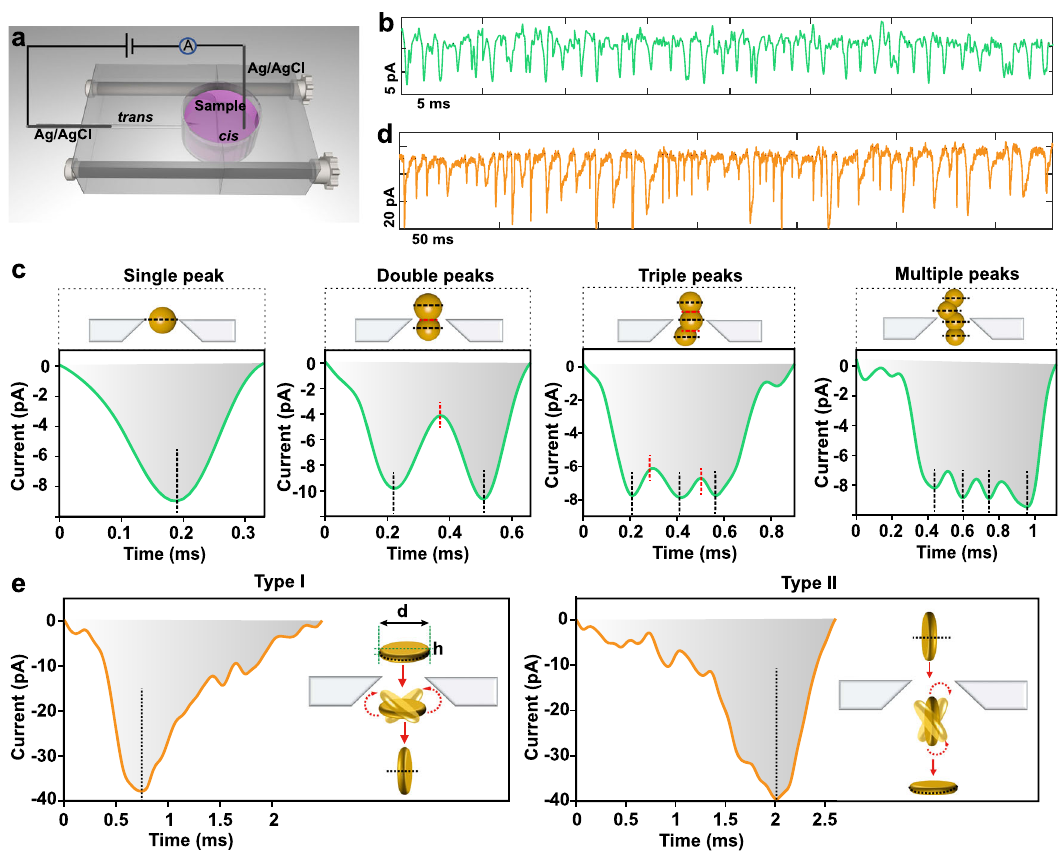
Fig. 2 Nanopore analysis of Au nanospheres and Au nanoplates. a Schematic of the nanopore experimental setup with a nanopipette and fl uid compartments con fi ned by polymethyl methacrylate (PMMA). The sample is added to the cis chamber in a 5 mM KNO 3 solution. 50 mM KNO 3 is fi lled in the trans chamber. b Concatenate events from Au nanospheres translocation test using a ~20 nm quartz nanopore at a 1 V bias voltage. A total of 2612 events were obtained from the Au nanospheres. c Typical nanopore current – time peak shape dependence of Au nanospheres coalescence states. Schematic of Au nanospheres translocation. d Concatenate events from Au nanoplates translocation test using a ~120 nm quartz nanopore at a bias voltage of 300 mV. A total of 761 events were obtained from the Au nanoplates. e Typical current – time peak shape for Au nanoplates. Schematic illustration of possible rotational tumbling of Au nanoplates in the nanopore sensing